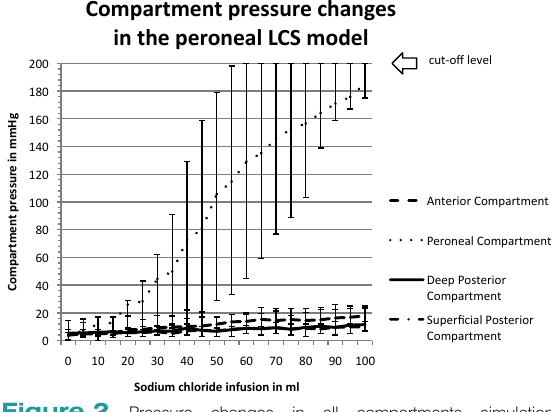
Figure 1. Pressure changes in all compartments simulating an anterior local compartment syndrome (LCS) in six cases.